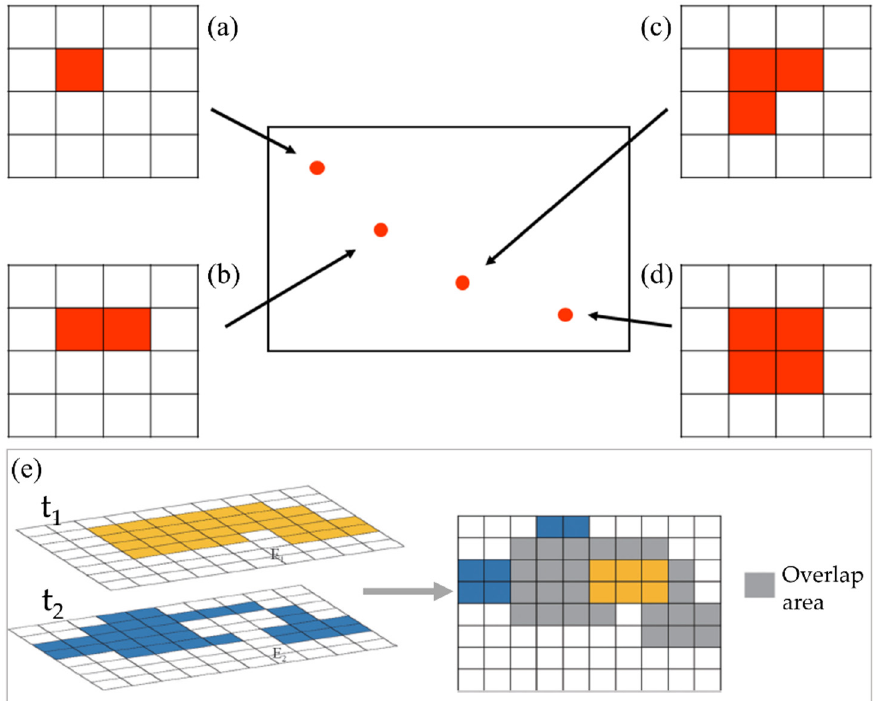
Figure 2. Schematic diagram of a regional heatwave event identification method considering temporal continuity and spatial dynamics ( a – d ) Identification process for a single regional heatwave event; ( e ) The process of determining the continuity of heatwave events in time and space, which is cited from [58] .